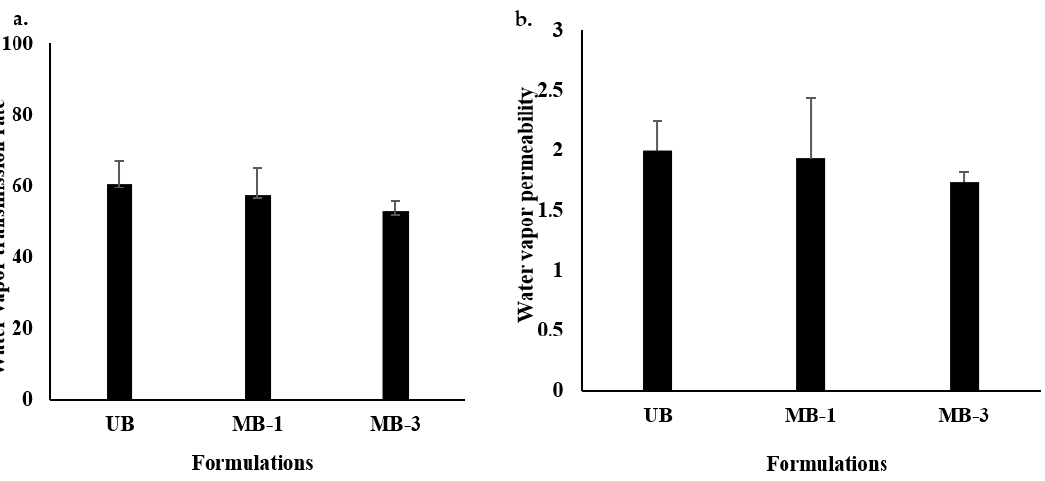
Figure 2. ( a ) Water vapor transmission rate; ( b ) water vapor permeability across various film formulations. Table 2. WVTR and WVP along with standard deviation of blend films.